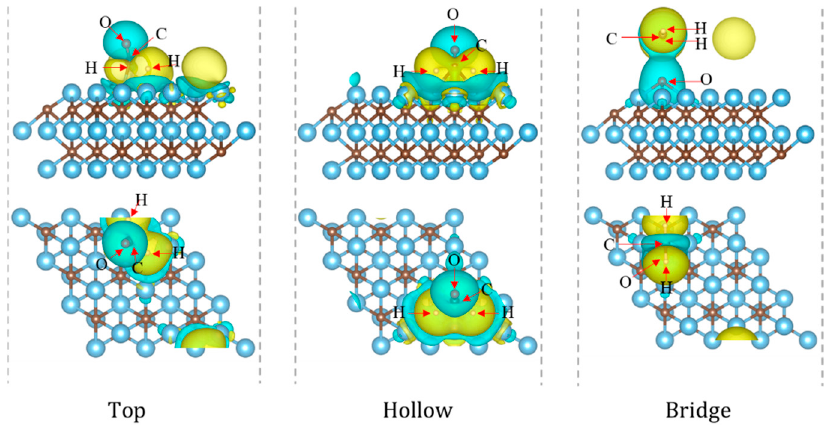
Figure 2. Side and top views of the differential charge density plots of the stable adsorption con- figuration of HCHO on the Ti 3 C 2 surface. (Isosurface value is 0.002 e/Å 3 ).